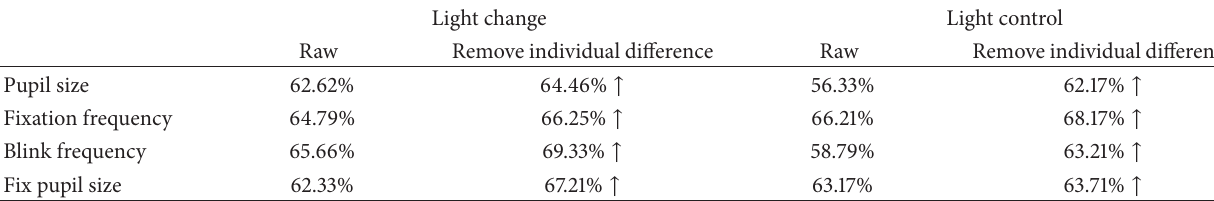
Table 4: Single feature’s recognition rates.